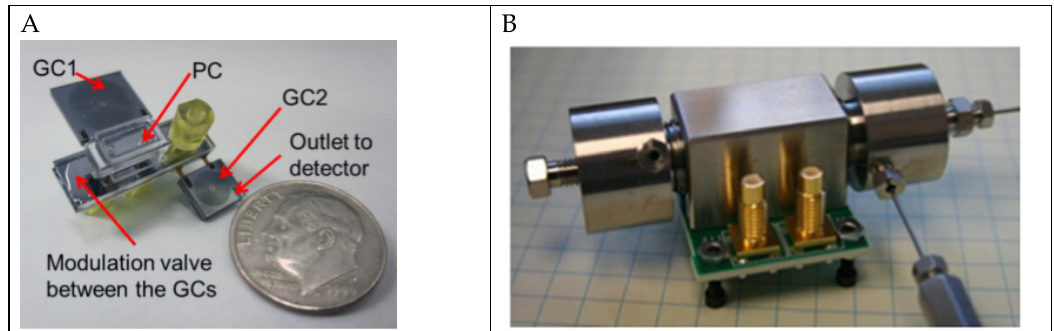
Figure 4. ( A ) Prototype of the microPC-microGCxGC subsystem. ( B ) Prototype of the mini-PDID. Reproduced with the permission of Reference [20]. Copyright Sandia National Labs.